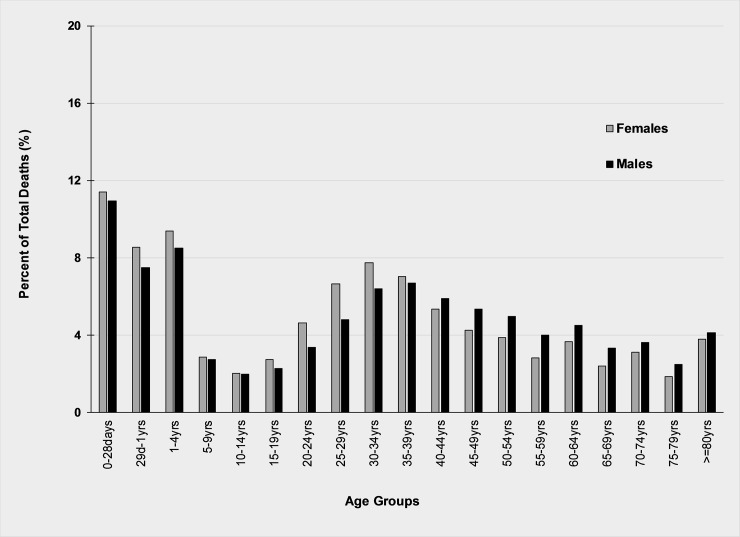
Age and sex distribution of hospital deaths, 2006–2015.